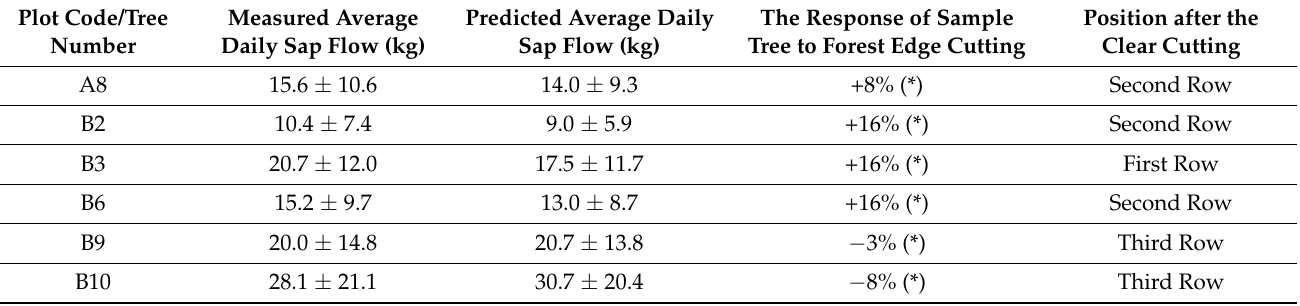
Figure 3. The diurnal mean sap-flow pattern of the study plots. G: sap flow (kg day − 1 ). ∆ with red color: the measured sap flow of C p . X with blue color: the measured sap flow of Tp. □ with green color: the predicted values of T p . Table 4. The effect of forest-edge clearance on sap flow of sample trees. “+” represents an increase, and “ − “represents a decrease in sap flow. (*) denotes statistical significance at p < 0.05 level.